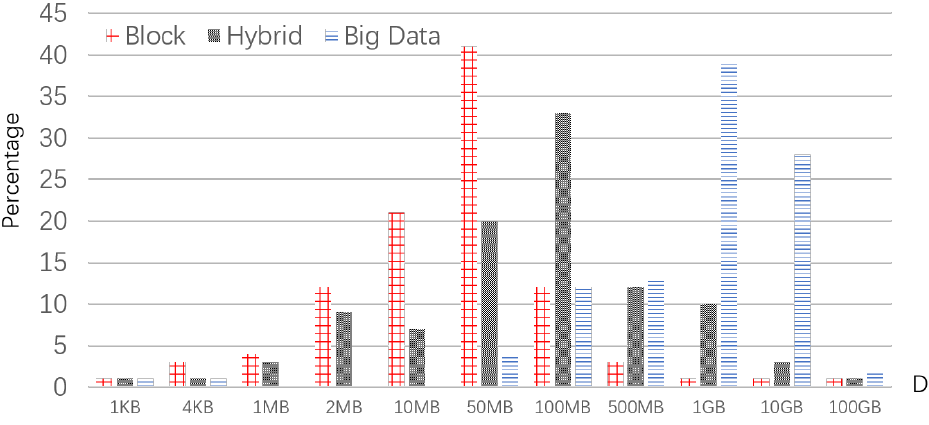
Figure 2. Distribution of data sizes under three workloads. The X axis is the data size range. For example, 4 KB includes data sizes ranging from 1 KB–4 KB. The Y axis is the percentage of each data size range.